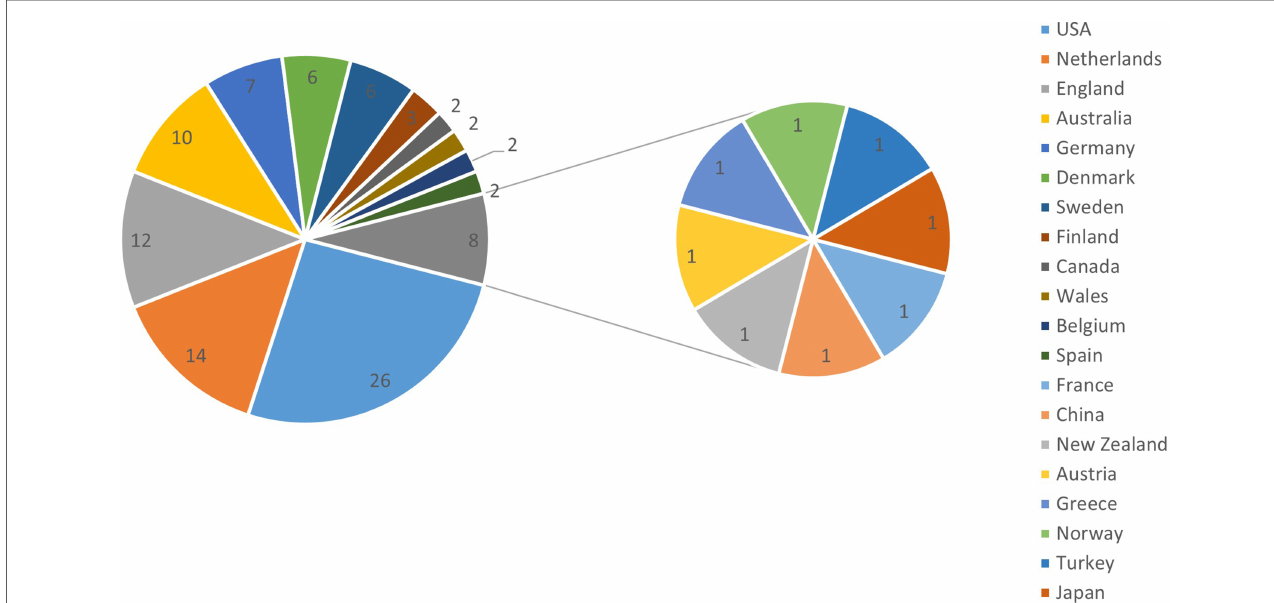
FIGURE 3 National distribution of the top 100 articles cited in tennis elbow. Note: the numbers in the pie chart represent the number of articles, and the different colors correspond to the countries or regions on the